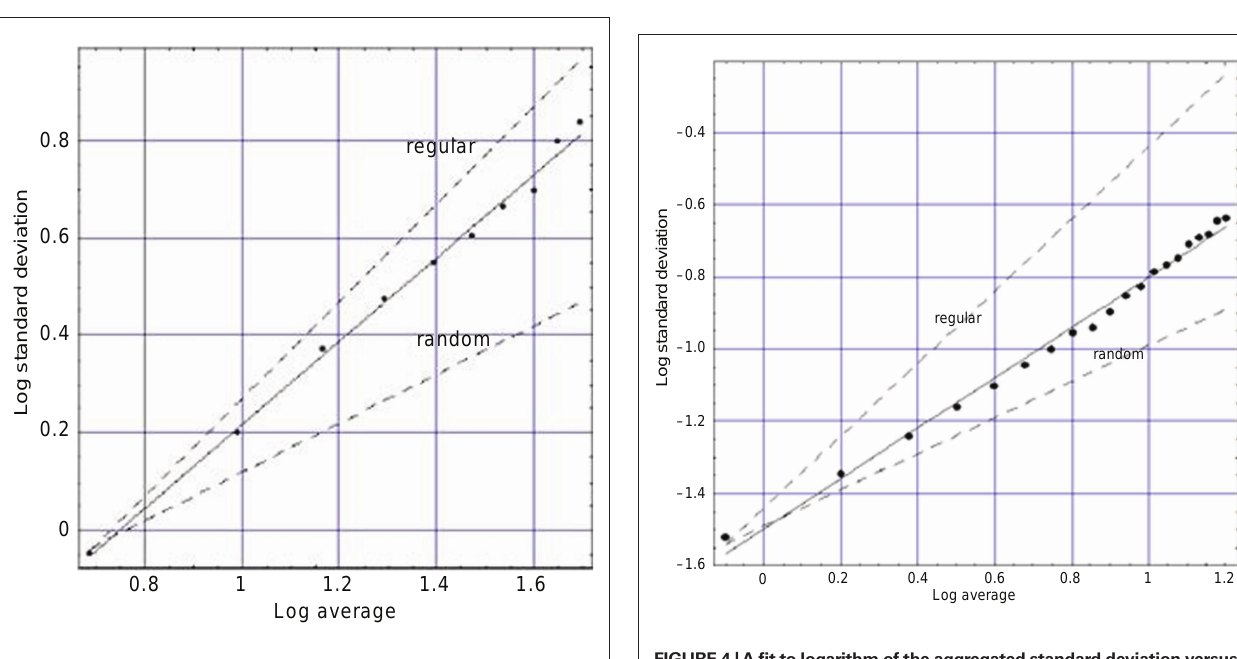
Figure 4 | A fit to logarithm of the aggregated standard deviation versus the logarithm of the aggregated mean of SrV data for a typical walker (West, 2006a) is depicted. The points are calculated from the data and the solid curve is the best least-square fit to the processed SRV data and yields a fractal dimension D = 1.3 midway between the curve for a regular process ( D = 1) and that for an uncorrelated random process ( D = 1.5) as indicated by the dashed